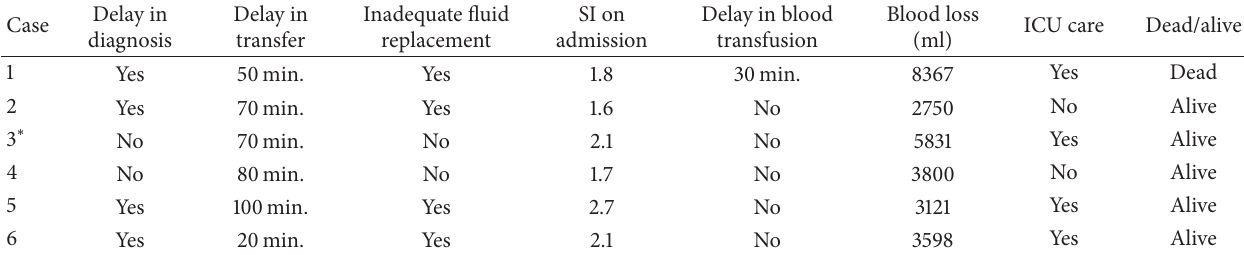
Table 2: Comparison of the resuscitate profile and outcome among the group with uterine inversion. Results are expressed as the number of individuals. ∗ Geographical disadvantage for transfer (more than 40 minutes by ambulance car). SI: shock index, min.: minutes.